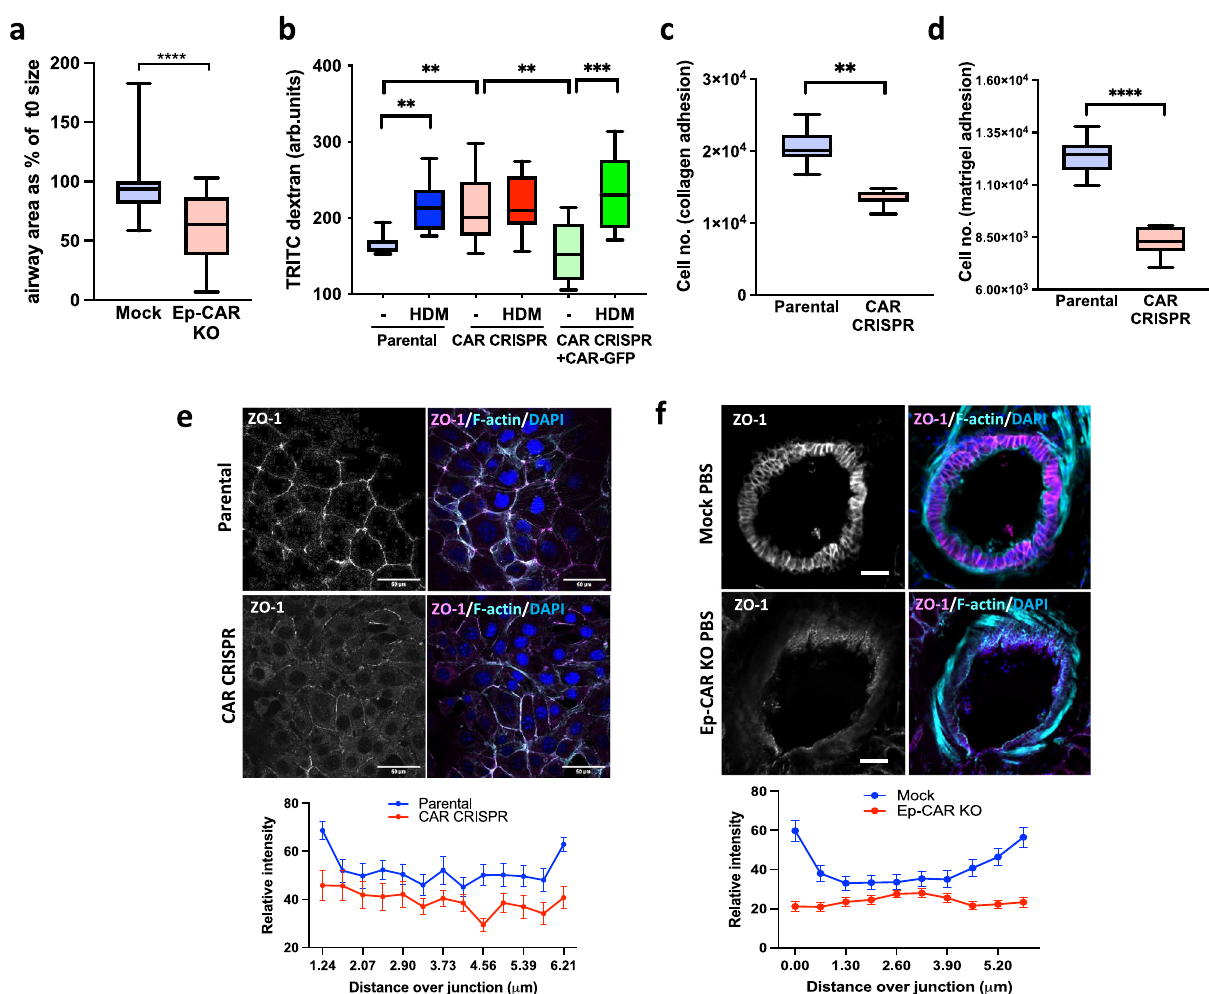
Fig. 3 | CAR promotes bronchial epithelial monolayer integrity. a Airway dia- meter in PCLS from Mock or Ep-CAR KO mice subjected to 0.5g/ml of Meta- choline for15min. Graph shows airway area after 15minas % ofstarting size from 35 airways per condition from 10 different mice per group (1 PCLS per mouse) representing 2 independent experiments. b Permeability assays in speci fi ed cell lines showing levels of TRITC-dextran passed through cell monolayers±HDM. Data is from 3 wells per condition per experiment: representative of 3 experi- ments. c , d Numberofadherent cellstocollagenI c or Matrigel d coatedwells2h post-plating. Data is from 9 wells per condition: representative of 3 experiments. e Representative confocal images of speci fi ed cells stained for ZO-1 (magenta), F-actin (cyan) and DAPI (blue). Scale bar: 50 μ m. Graphs below show quantitative